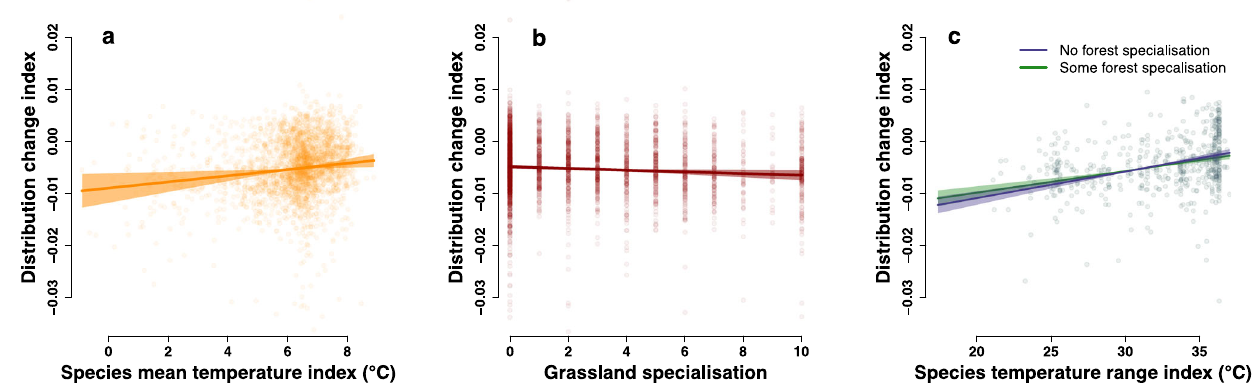
Fig. 2 | Correlates of regional distribution changes in plant species over time. Points and lines show the relationships between measures of a species mean temperature index (the average temperature experienced by a species across its Swedish range 10 ), b grassland specialisation (the proportion of a species ’ popu- lation in grassland habitats 13 ) and c species temperature range index (the range of temperatures experienced by a species across its Swedish range 10 ) with Fres- calo distribution change index 11 , based on a linear mixed effects model ( n =2771 estimates of change from 1431 species in the four provinces). In c , the effect of